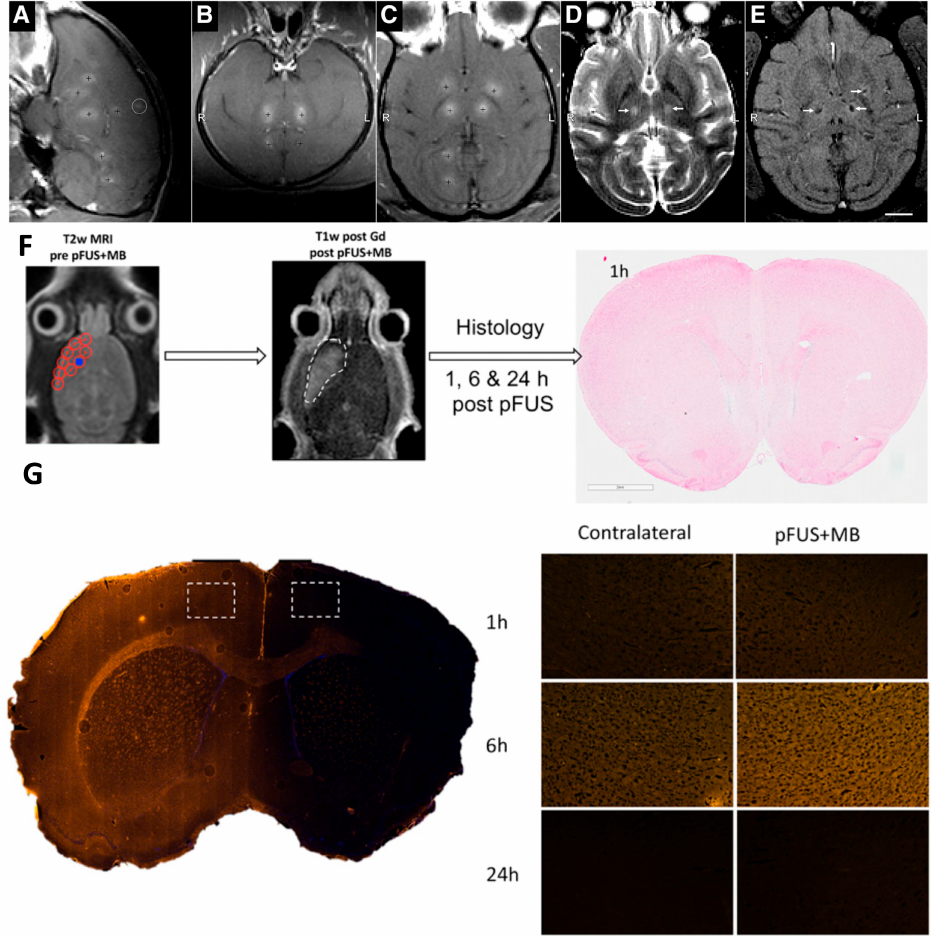
Figure 2. Synergistic effect of focused ultrasound and MRI for BBB theranostics. ( A – C ) BBB disruption in monkey brain tissue following focused ultrasound and microbubble targeting of a single tissue site (white circle; R, right and L, left). ( D , E ) After the interruption of the BBB presentation, an MR contrast agent was added, and this imaging agent penetrated the brain (white arrows). ( F ) Experimental design for the histological analysis of a rat brain treated with focused sonication. Targeted concentrated ultrasound on spots approximately 2 mm in diameter (red circles) and a Gd-enhanced T1-weighted image after using focused ultrasound. The white dashed line outlines the contrast-enhanced results, and no apparent damage was observed on H&E. ( G ) After the focused ultrasound and microbubble treatment, the white dashed rectangles indicate the accumulation of albumin occurring through the open exudative BBB. Adapted with permission from Refs. [99,100]. Copyright 2012 American Association for Cancer Research and 2016 Proceedings of the National Academy of Sciences of the United States of America.